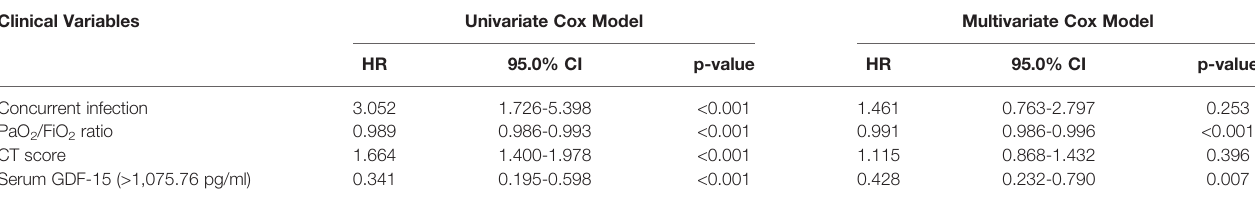
TABLE 5 | Predictors for survival by univariate and multivariate Cox regression models in IPF patients. Clinical